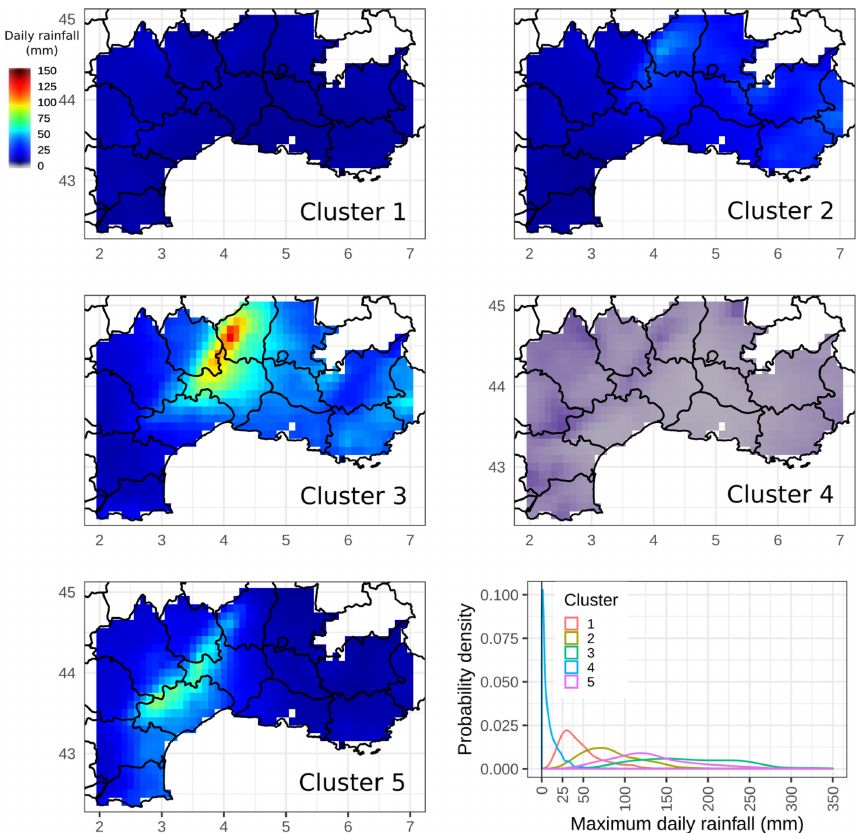
Figure 3. Rainfall composites (mmd − 1 ) for the five clusters selected by the K -means algorithm. The bottom right panel shows the probability density distribution of the maximum daily rainfall (mm) for each cluster